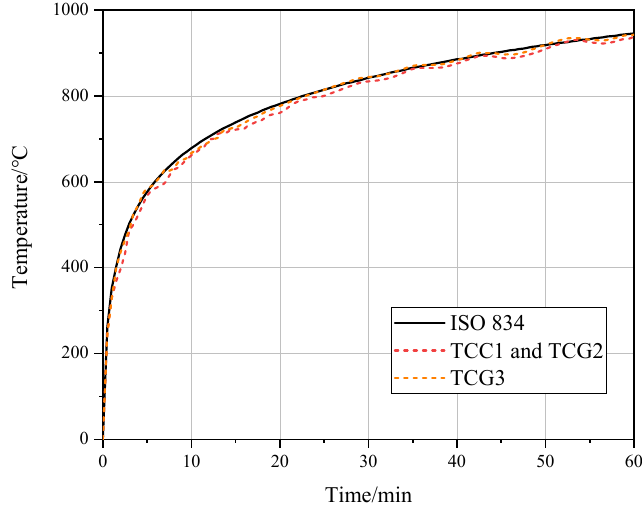
Figure 8. Furnace temperature-rising curves.